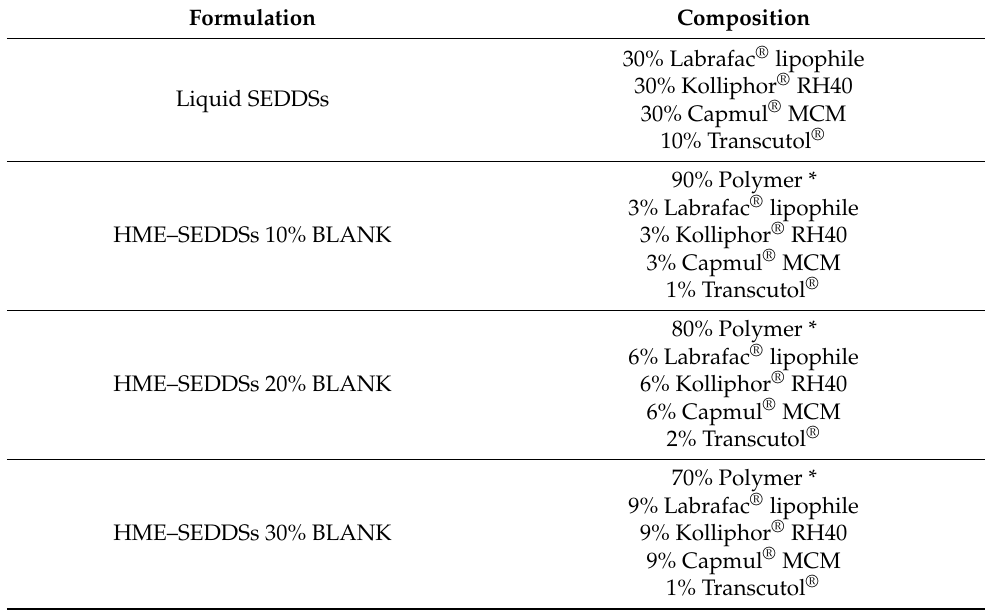
Table 1. Composition of liquid SEDDSs and HME–SEDDSs prepared in this study. Formulation